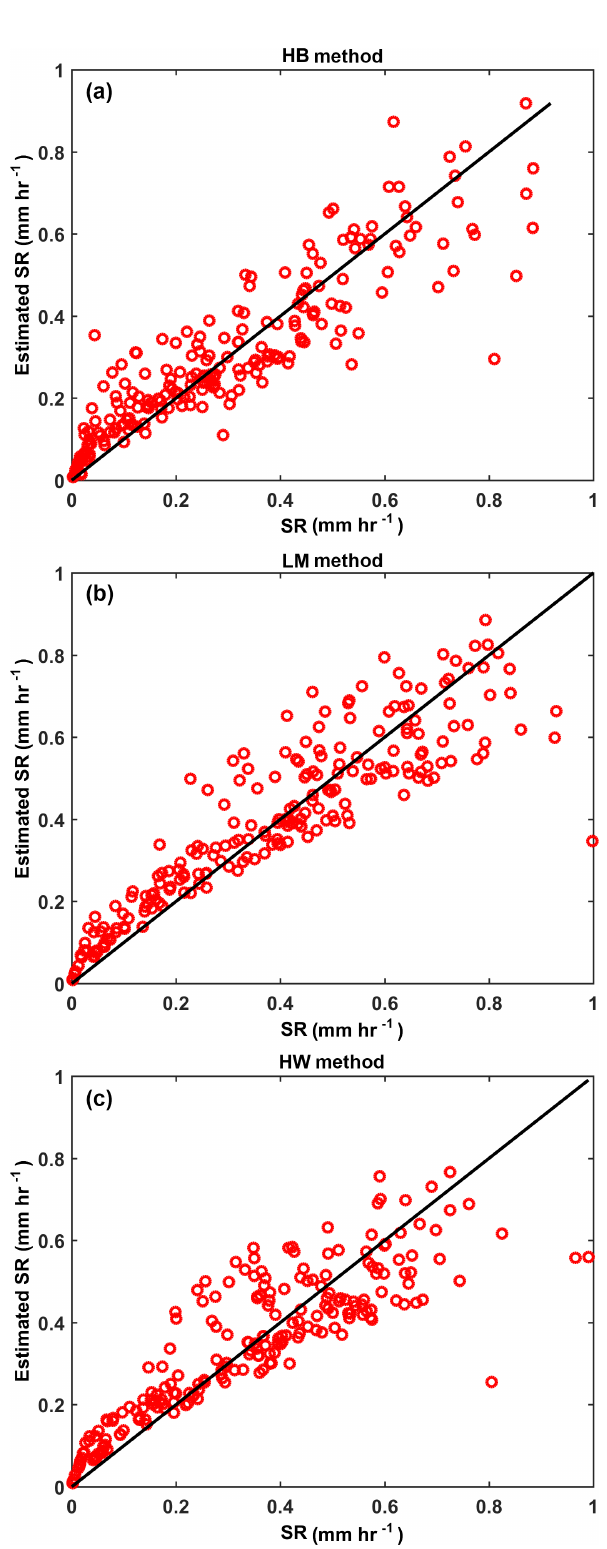
Figure 14. Estimated SR using Z e and DWR of the 2DVD and Eq. (10) vs. 2DVD SR scatterplot for the HB method (a) , LM method (b) , and HW method (c) .